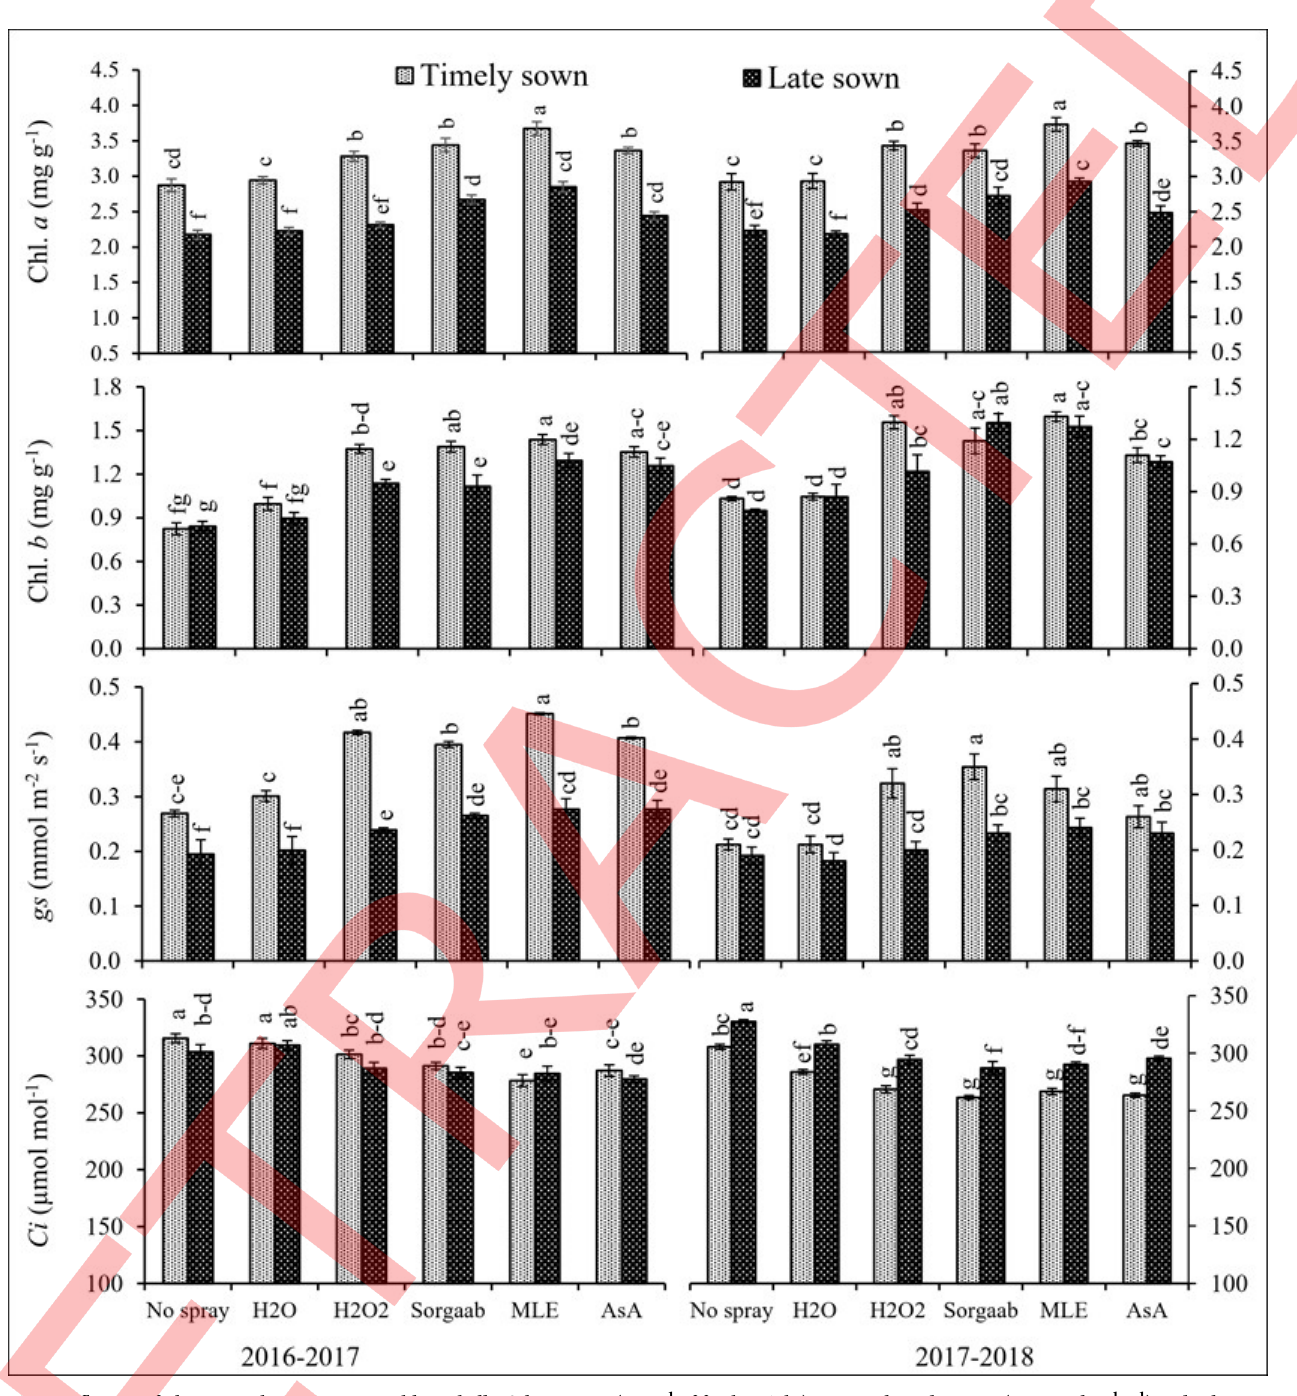
Fig 1. Influence of plant growth promoters on chlorophyll a & b contents (mg g -1 of fresh weight), stomatal conductance (gs; mmol m -1 g -1 ) and sub- stomatal CO 2 concentration (Ci; μ mol mol -1 ) of quinoa cultivated under timely and late sown conditions during growing seasons of 2016–2017 and 2017–2018.